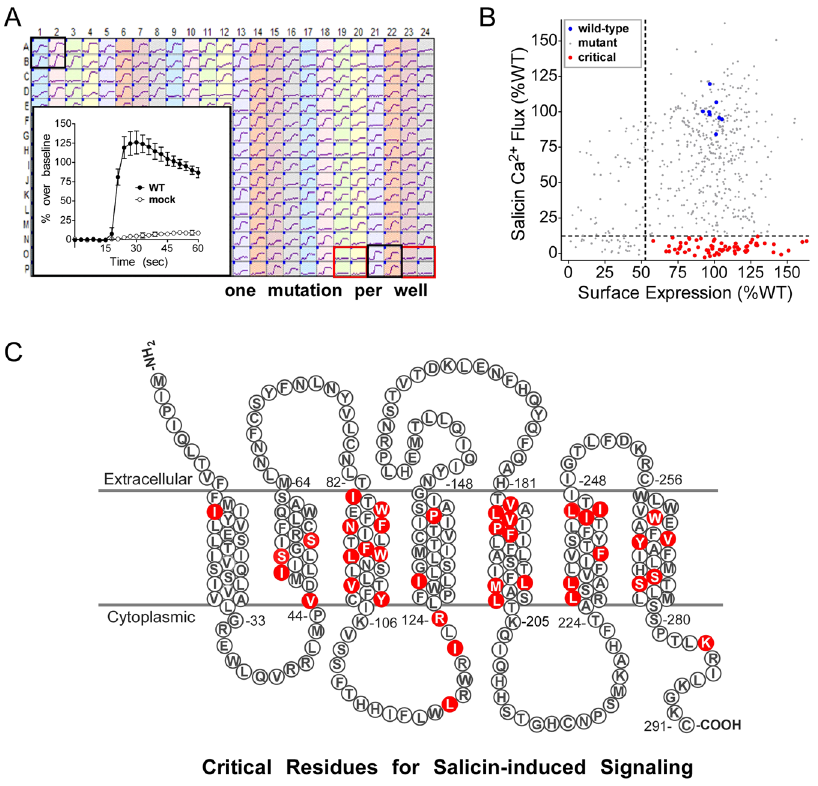
Figure 1. Identification of residues critical for salicin-dependent signaling. ( a ) Calcium traces obtained from a representative 384-well plate of HEK-293T cells transfected with the TAS2R16 mutation library and stimulated with 3 mM salicin. Each library plate contained 8 positive control wells used for normalization of Ca 2 + flux measurements (wild-type TAS2R16; black boxes) and 8 negative controls wells (non-specific vector; red boxes). Individual traces for positive and negative control wells are shown in the inset (average + / − standard deviation). ( b ) Plot showing TAS2R16 salicin-induced Ca 2 + flux as a function of cell surface expression (detected by immunofluorescent detection of an N-terminal FLAG tag) for each clone in the TAS2R16 mutation library. Values are normalized to wild-type, shown in blue. Critical clones marked in red displayed less than 12% (mean of negative controls + 3 * SD) of wild-type TAS2R16 Ca 2 + flux activity and greater than 53% (mean of positive controls - 3 * SD) of wild-type TAS2R16 cell surface expression. ( c ) Diagram of TAS2R16 showing the location of residues whose mutations eliminated Ca 2 + flux for salicin (i.e. flux < 12%; highlighted in red) and gave expression on the cell surface at > 53% of wild-type. TMs were predicted using TMHMM Server v.